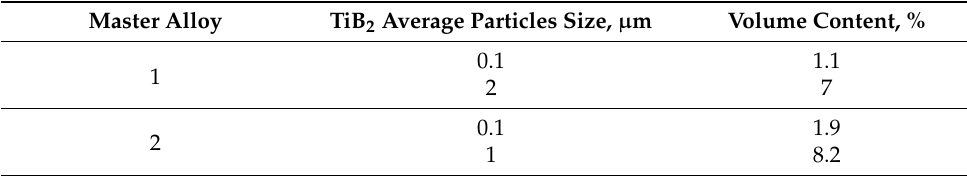
Table 1. TiB 2 particle sizes and volume content in the Al-TiB 2 master